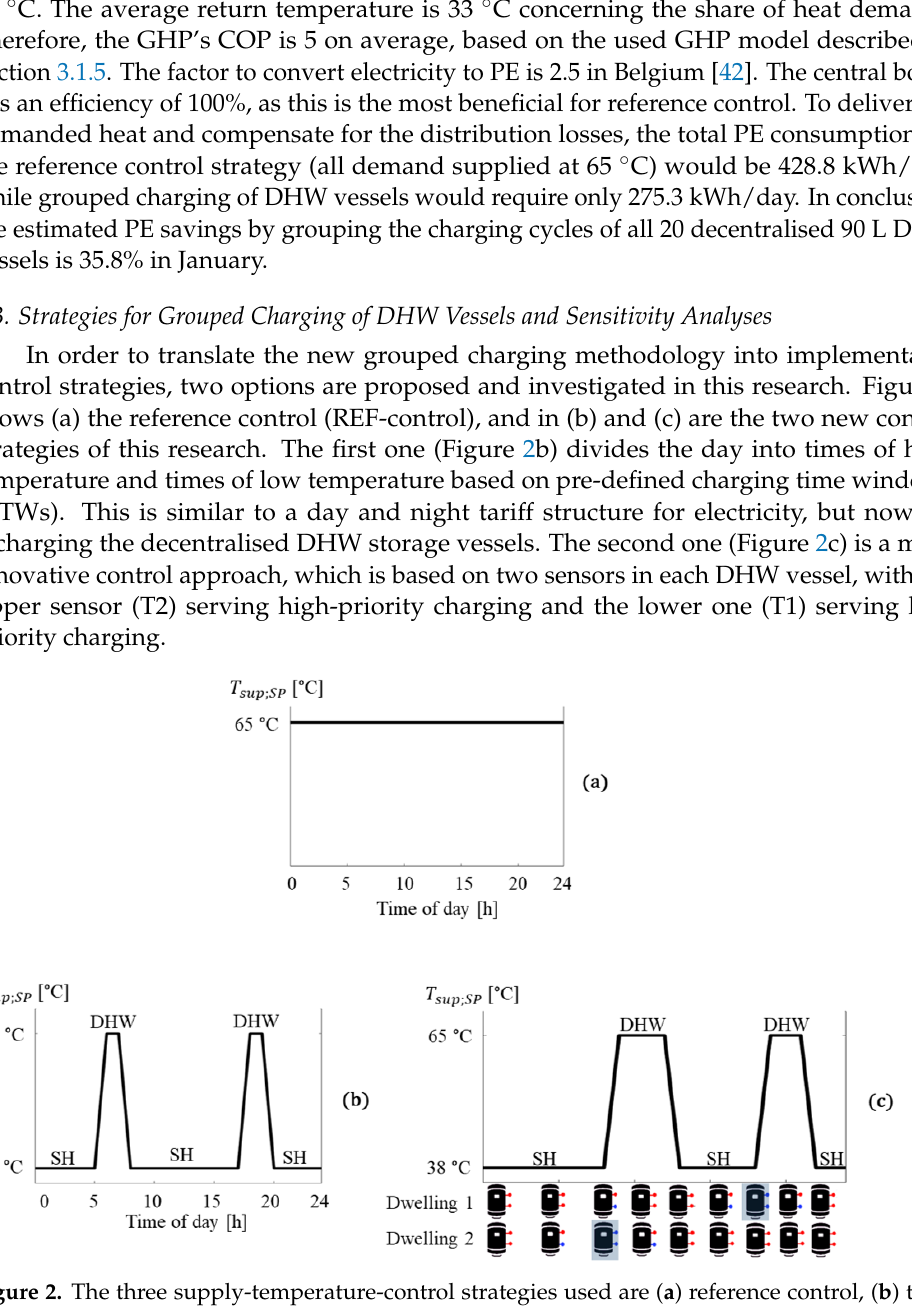
Figure 2. The three supply-temperature-control strategies used are ( a ) reference control, ( b ) time- based control (TB-control), and ( c ) two-sensor control (2SC). For TB-control, T sup ; SP is 65 ◦ C during two pre-defined charging time windows (CTWs) and 38 ◦ C otherwise. A DHW vessel stops recharging during a CTW once the bottom sensor reaches the DHW set point. For 2SC, each DHW vessel has two temperature sensors. The T sup ; SP is 65 ◦ C when the upper sensor (T2) of one of the DHW vessels drops below the DHW set point. Then, all DHW vessels with a too-cold lower sensor (T1) are recharged. As soon as the temperature of the lower sensor of all DHW vessels rises above the set point, the central supply temperature drops back to 38 ◦